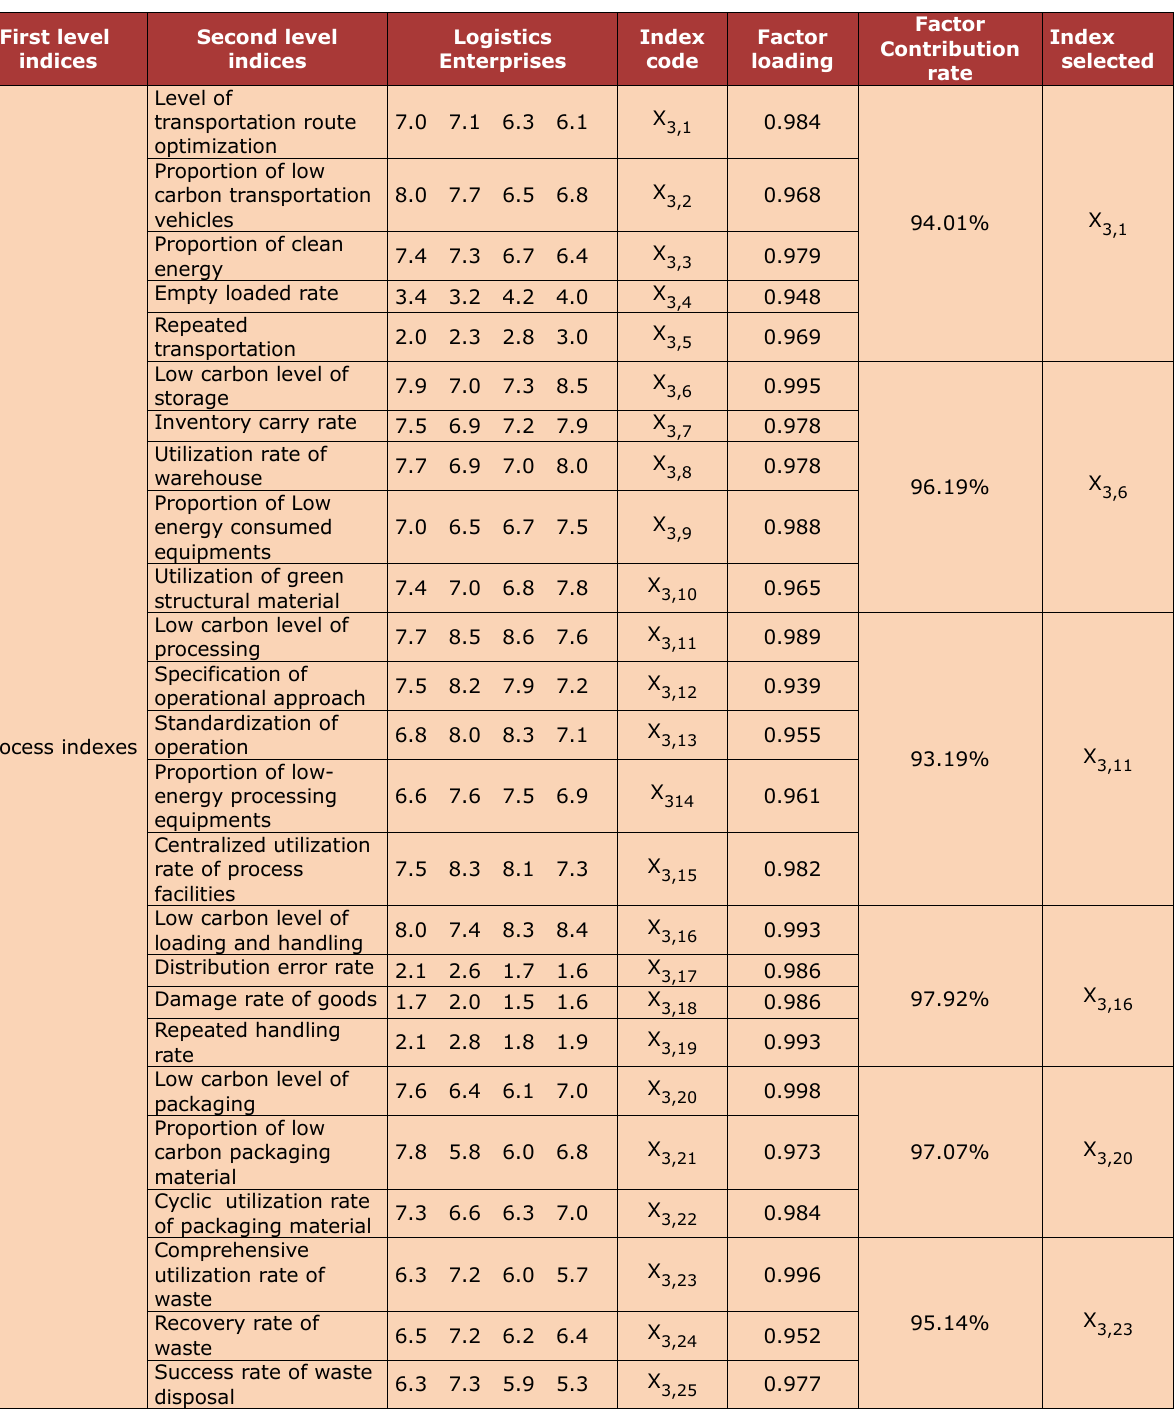
Table 1. Low carbon evaluation index system and results of clustering-factor